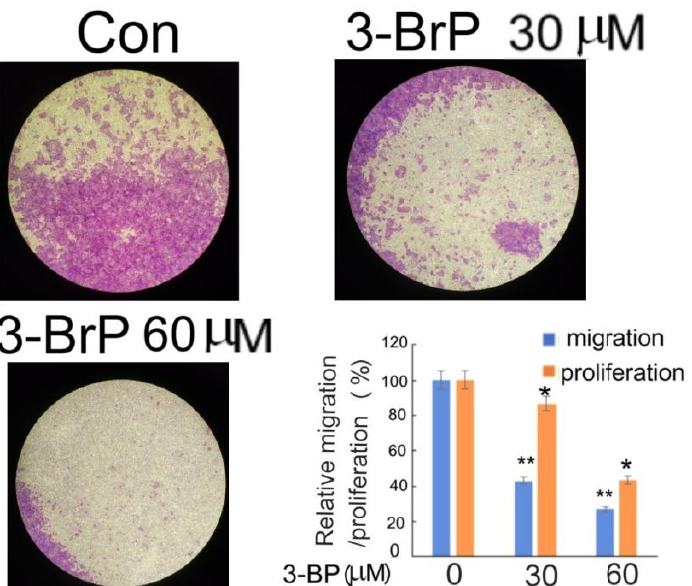
Figure 6. Glycolysis inhibitor 3-Bromopyruvate suppressed HuCCT1 progression. HuCCT1 cells were treated with 3-Bromopyruvate (3-BrP) at indicated concentration for 48 h using the sample of untreated cells (0 µ M 3-BrP) as controls (Con). Transwell migration assay and cell proliferation assay were performed. On the upper and left panels, the images of migration assay are the crystal-violet-stained, migrated cells pictured under a 40× magnification. Cell proliferation was analyzed using the MTT assay described in Materials and Methods. The resultant quantitative data of migration (blue bars), using ImageJ software, and cell proliferation (orange bars) assay are shown in the lower right panel. Relative motility and cell proliferation were calculated taking the data of the control (0 μ M 3-BrP) group as 100%. (**) and (*) represent the statistical significance ( p < 0.005 and 0.05, respectively, N = 4) of the difference between the indicated samples and the control.